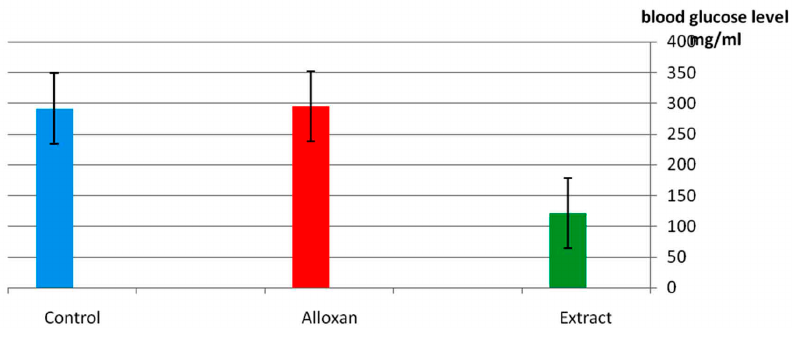
Fig. 4. Effect of the extract in blood glucose level of laboratory rats. After 6hrs of treatment n=5